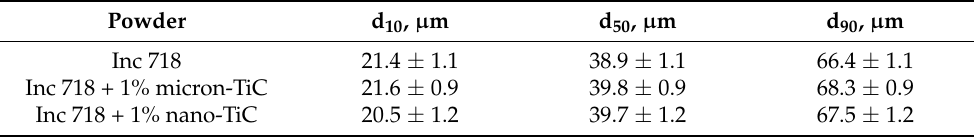
Table 3. Particle size distribution of the powders.